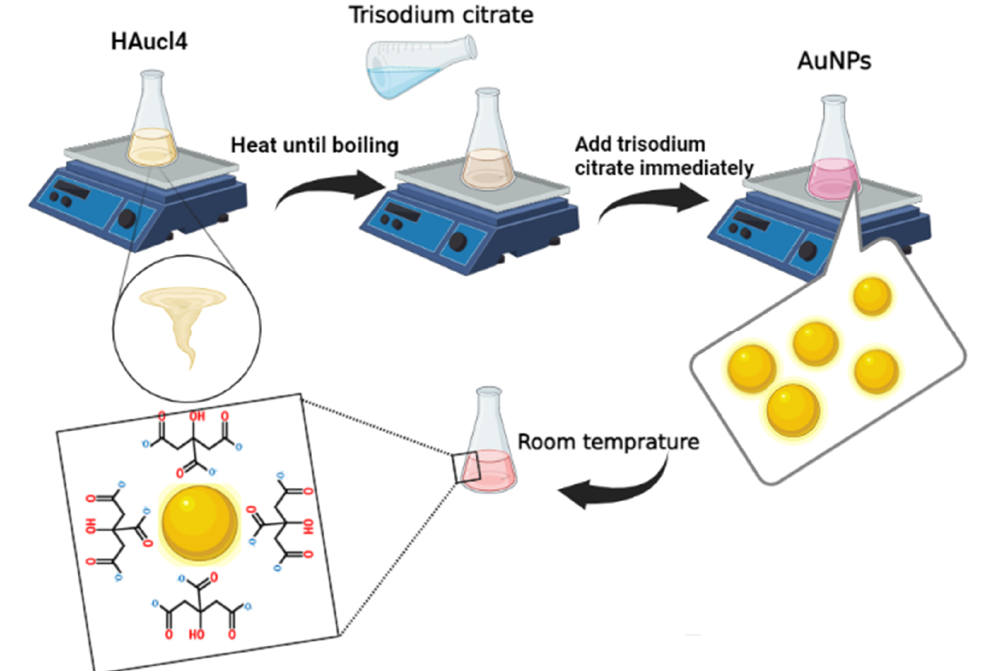
Figure 9. Schematic of gold nanoparticle chemical synthesis.